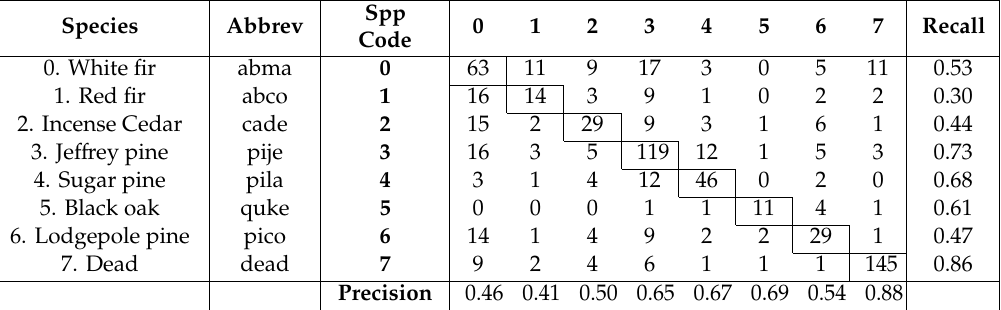
Table 4. The Red-Green-Blue classification confusion matrix for tree species identified using high-precision field GPS (rows) compared to the CNN model species prediction (columns; numbered labels refer to species numbers shown in row labels). Polygon (per-tree) from five combined k-folds cross validation test